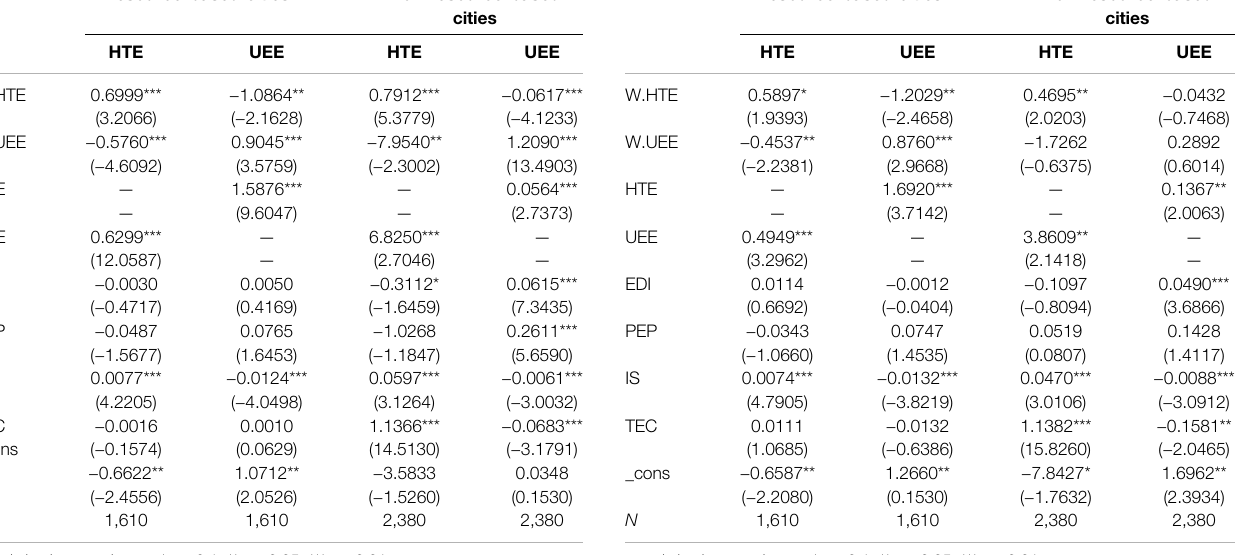
TABLE 5 | Estimation results of cities by resource Endowment (geographical distance spatial weight matrix). Resource-based cities